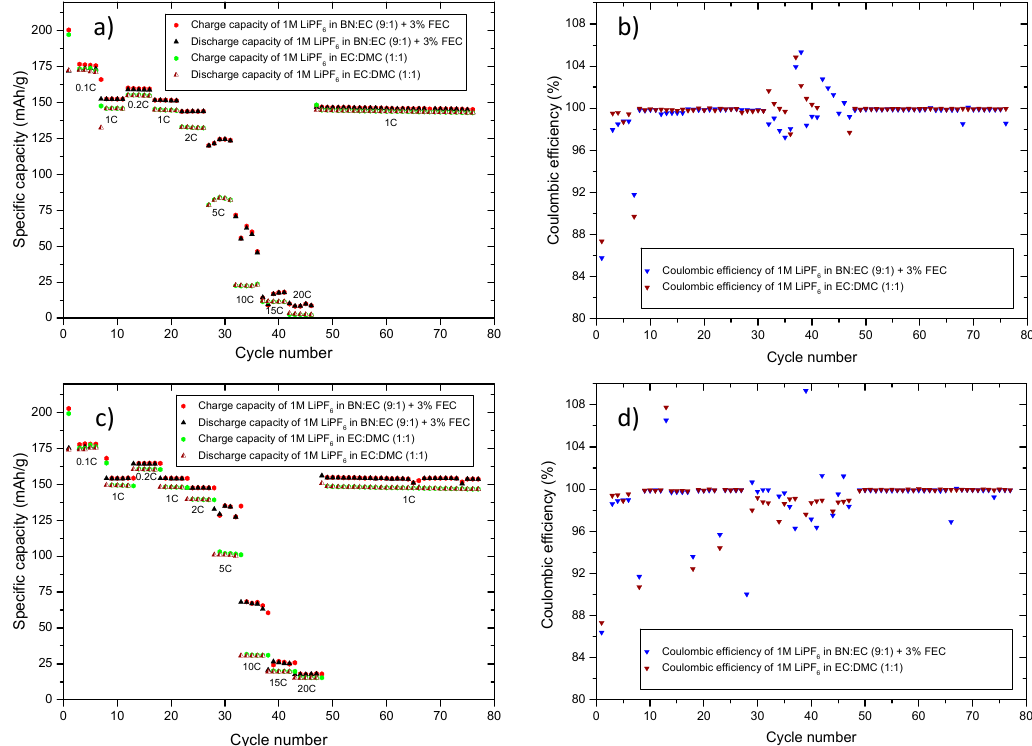
Figure 5. Cycling profiles and Coulombic e ffi ciencies of the NMC / graphite cells containing 1M LiPF 6 in BN:EC (9:1) + 3% FEC and 1M LiPF 6 in EC:DMC (1:1) electrolyte formulations cycled in a voltage range of 3.00–4.30 V using a C-rate procedure ( a , b ) the C-rate of the charge step is increasing while the C-rate of discharge step stays constant at 1C and a C-rate procedure ( c , d ) where the C-rate of the discharge step is increasing whereas the C-rate of the charge step stays constant at 1C.